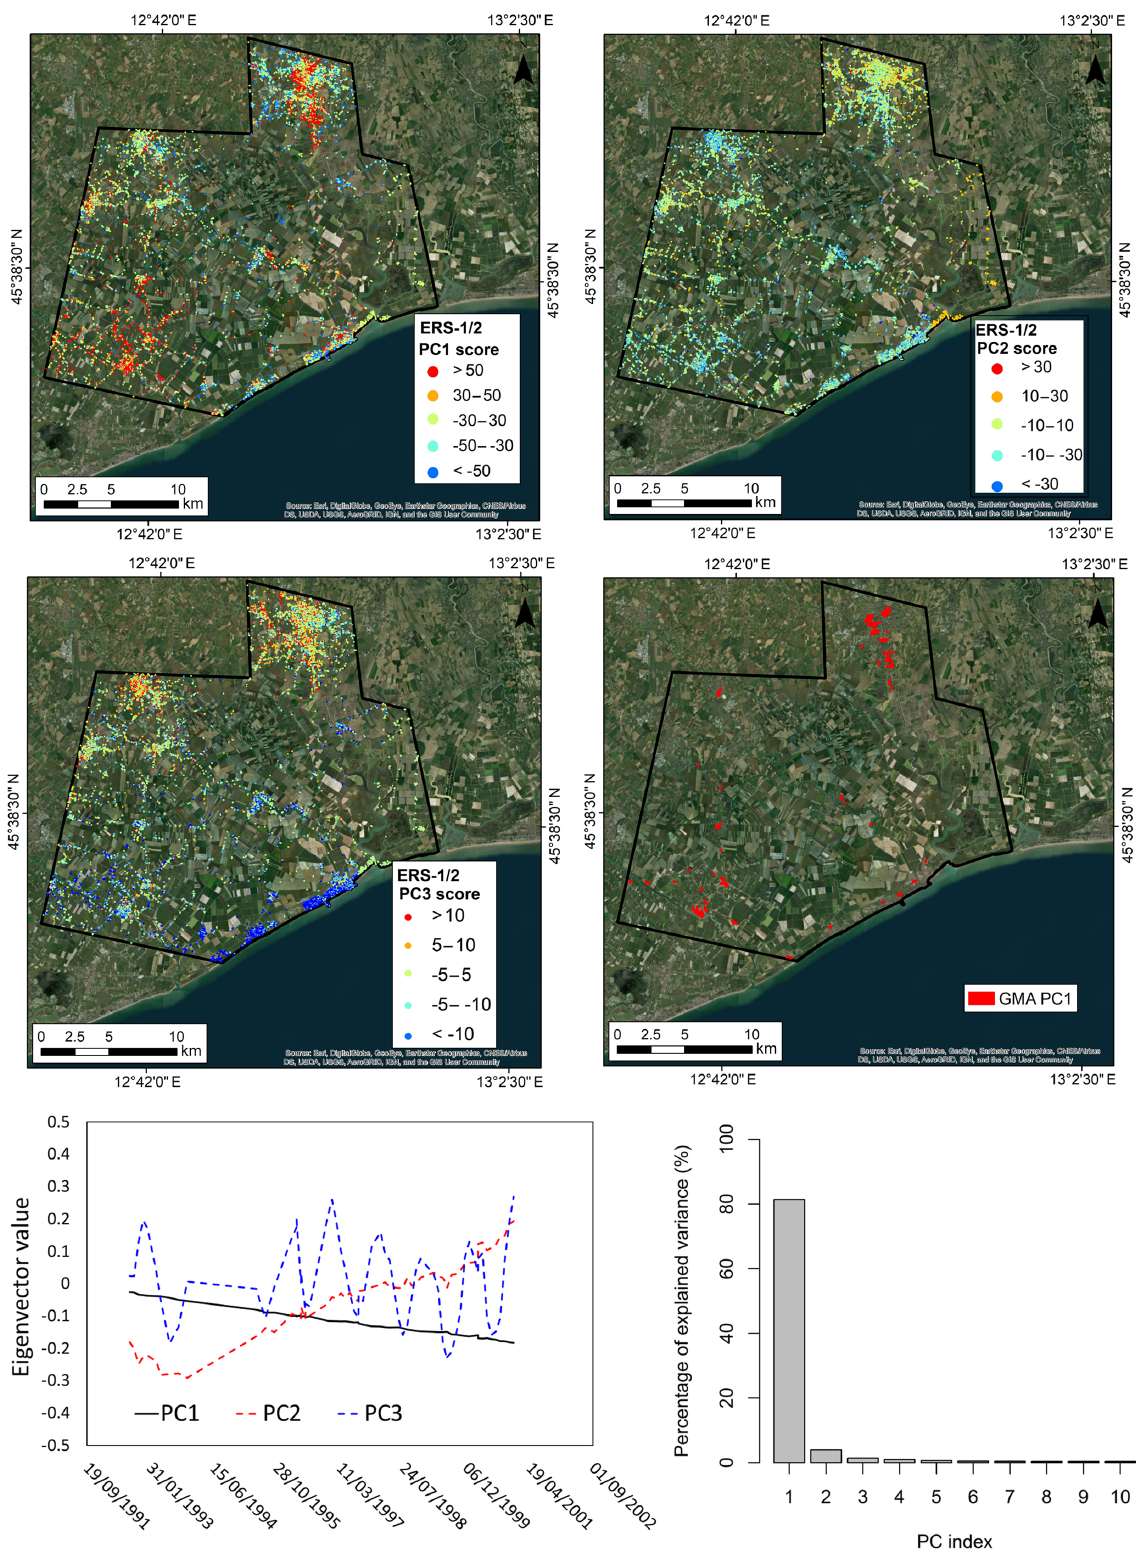
Figure 4. Principal component score maps and GMA mapping obtained using ERS-1/2 data for the period 1992–2000. Eigenvectors of the principal components (PC) and the percentage of the explained variance are also